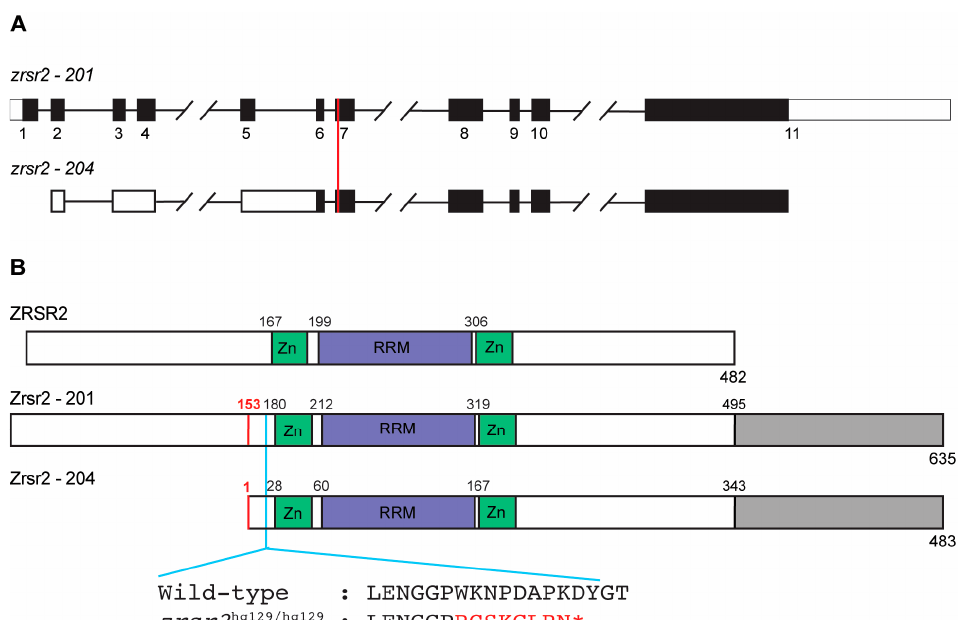
Figure 1. Genomic organization and functional domains of zebrafish Zrsr2. ( A ) A schematic of the genomic structures of zrsr2 isoforms 201 and 204, with exons shown as rectangles and introns as lines connecting the exons. Filled rectangles mark the coding sequence, and white rectangles mark the untranslated regions. The vertical red line marks the genomic target region of the sgRNA used for CRISPR/Cas9 knockout. ( B ) The alignment of the human ZRSR2 protein with isoforms 201 and 204 of zebrafish Zrsr2, showing the location of conserved functional domains: Zn = Zinc finger domains, RRM = RNA recognition motif. Gray color marks the extra C-terminal region in zebrafish Zrsr2. Black numbers indicate the amino acid number for the start of each domain. Red numbers mark the methionine at position 153 in isoform 201, which is the translation start site of Zrsr2-204. Blue line marks the location of the CRISPR/Cas9-induced mutation and partial amino acid sequences of WT and mutant proteins, with red color marking the frameshift and premature termination codon marked as *.